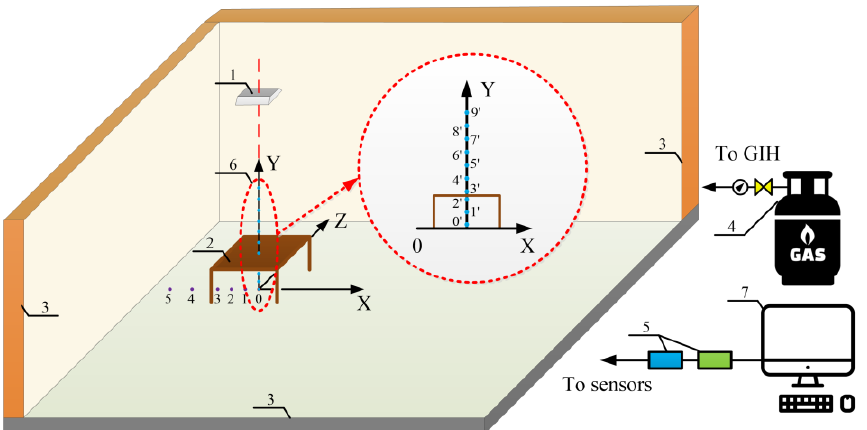
Figure 1. Scheme of the experimental area and thermocouple location: 1 — GIH; 2 — remote horizontal panel; 3 — enclosing structures; 4 — shut-off and control valves of the gas supply system; 5 — analog-to-digital converter (NI 9214) and data collection and transmission system (DAQ 9181); 6 — thermocouples (0 ′– 9 ′ thermocouple numbers); 7 — computer.